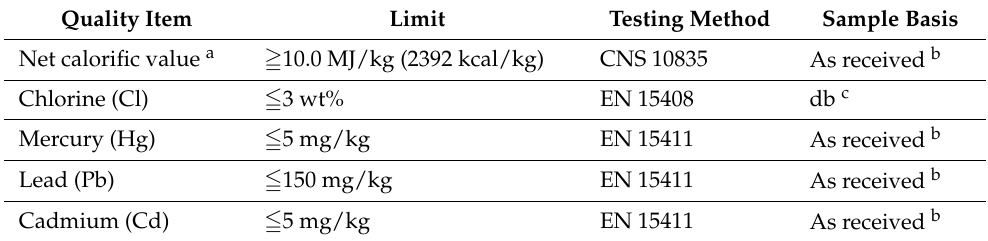
Table 1. Quality standards of solid recovered fuels (SRFs) in Taiwan.